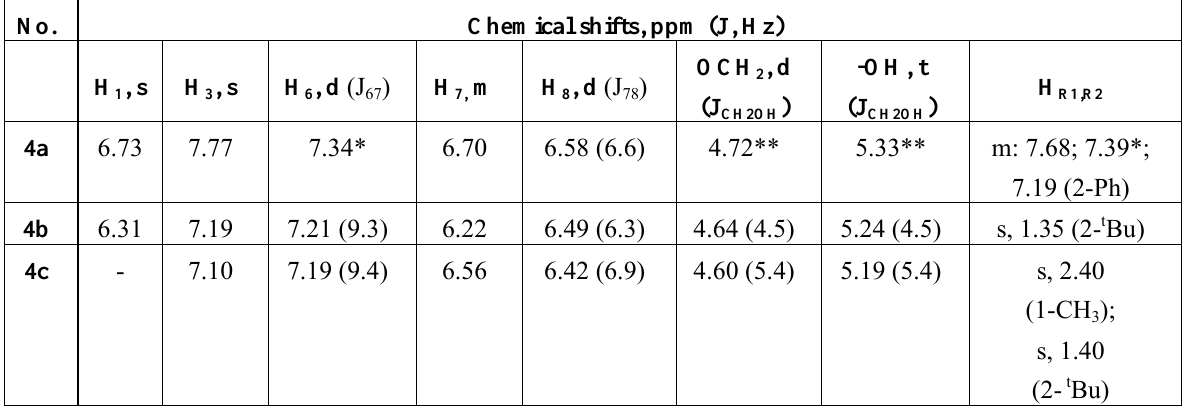
OH indolizines 2